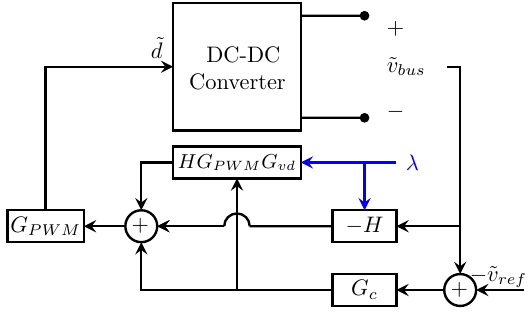
Figure 5. The proposed controller, emphasizing the modification to the controller in blue.